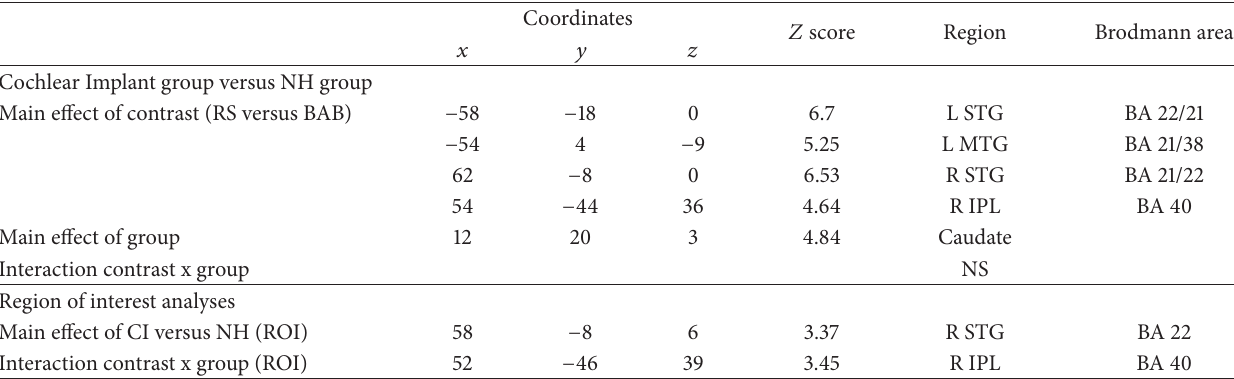
Cochlear Implant group versus NH